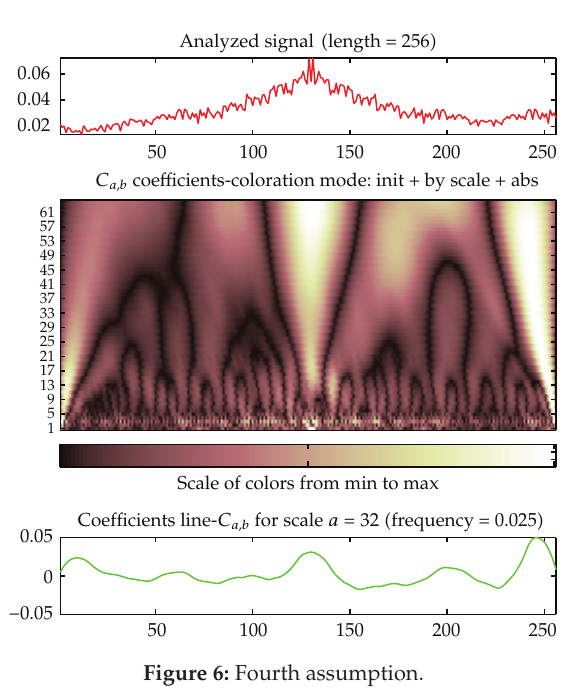
Figure 6: Fourth assumption.